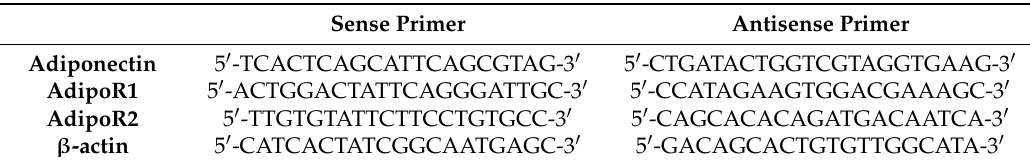
Table 2. Primers used for